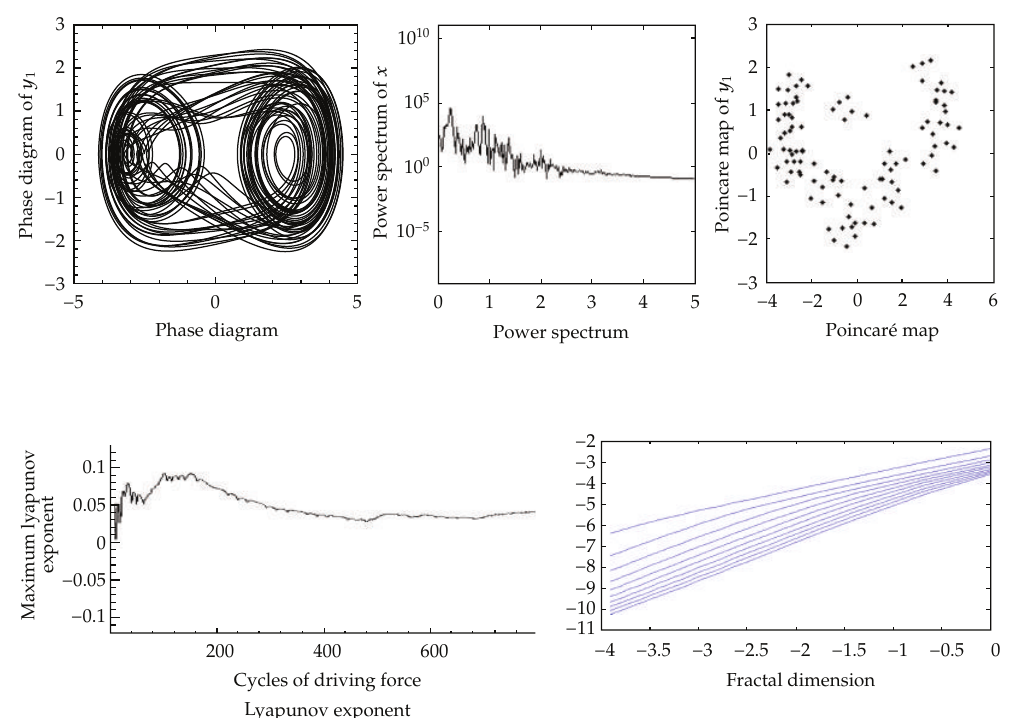
Figure 12: Simulation results obtained for gear-bearing system with s (cid:9) 3 . 6 for y 1 (cid:6) l ∗ (cid:9) 0 . 3 (cid:7) .